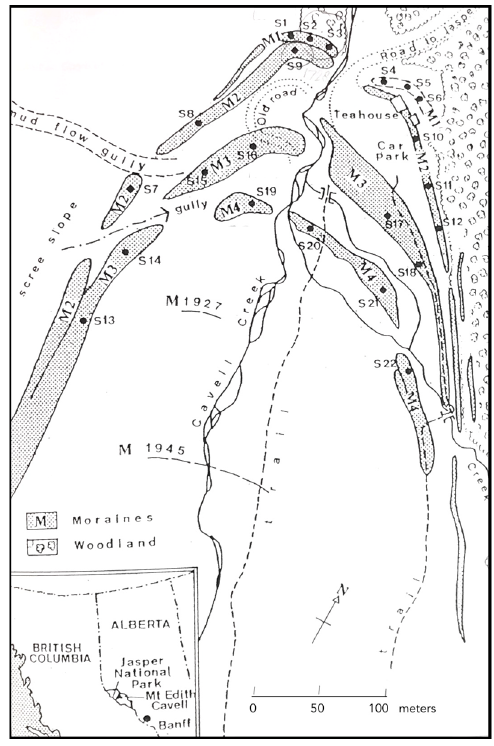
Figure 7. Map of the four Mount Edith Cavell moraines adapted from Luckman (1977). Sampling sites S1 to S22 [96].